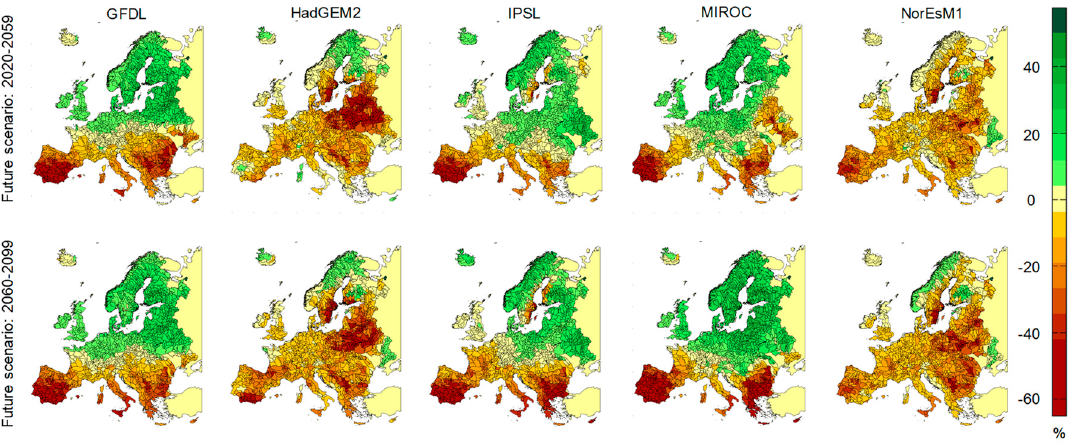
Figure 4. Changes (percentage) of mean annual runoff in future scenarios (2020–2059 and 2060–2099) compared with the reference scenario (1960–1999), according to different climate models and for the emissions scenario RCP4.5. Red shading represents a decrease of the mean annual runoff and green shading an increase.